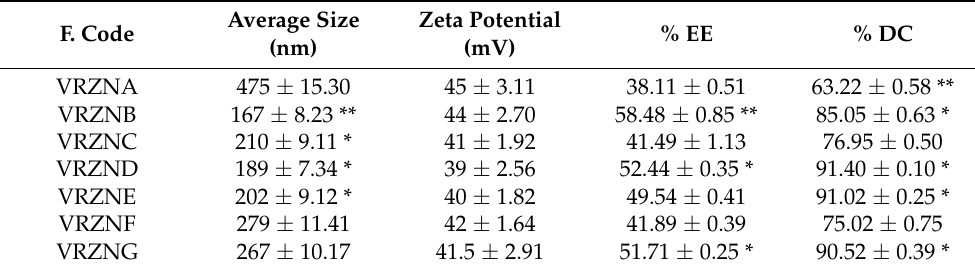
Table 2. Average particle size, zeta potential, % drug entrapment, and % drug content: n = 3, mean ± S.D., * p < 0.05 and ** p < 0.001 considered statistically significantly different. Average Size Zeta Potential F. Code % EE % DC (nm) (mV) VRZNA 475 ± 15.30 VRZNB 167 ± 8.23